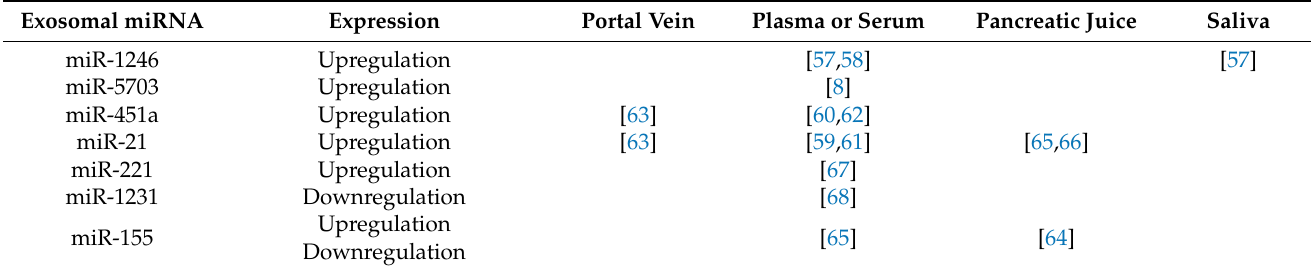
Table 1. The aberrant expression and distribution of TME-related exosomal miRNAs in